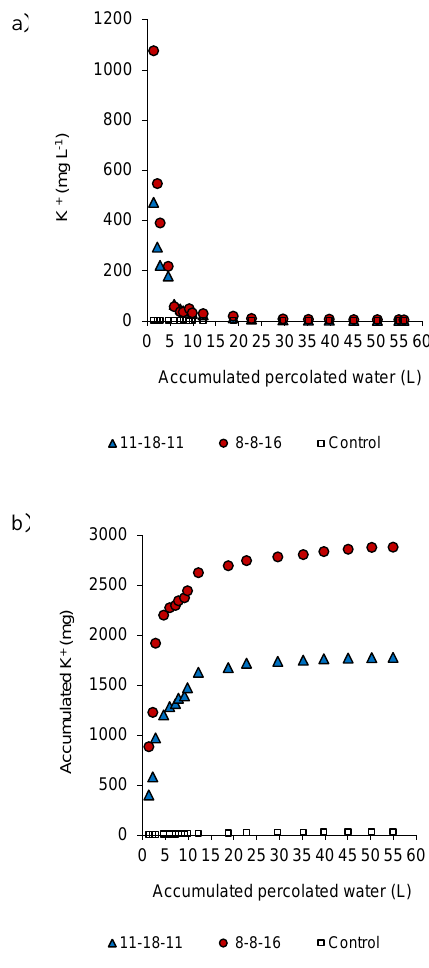
Figure 6. Potassium concentrations in leachates (a) and accumulated K + losses (b) from fertilized and control columns along the experiment (average of three replicates).